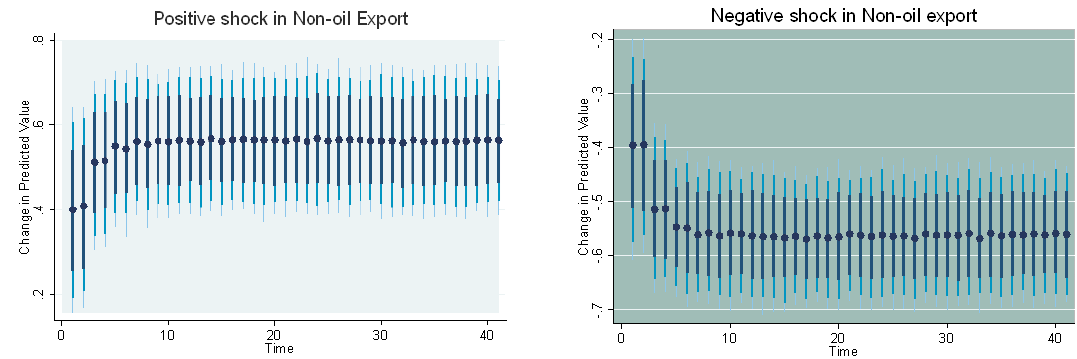
Figure 2. ± 10% shocks in non-oil